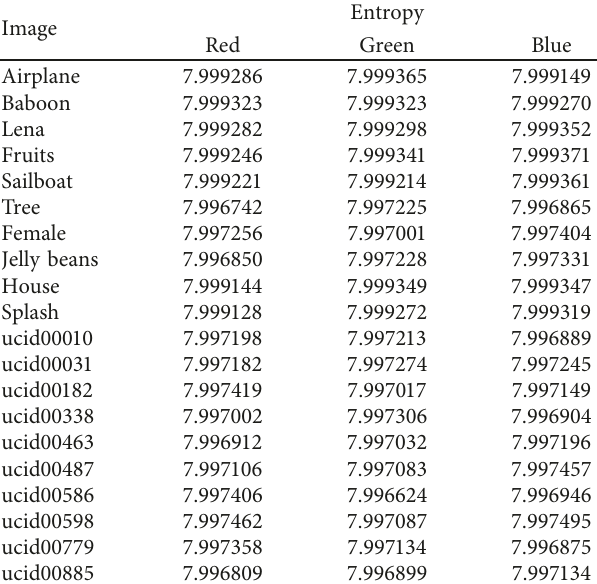
Table 6: Entropy analysis for five